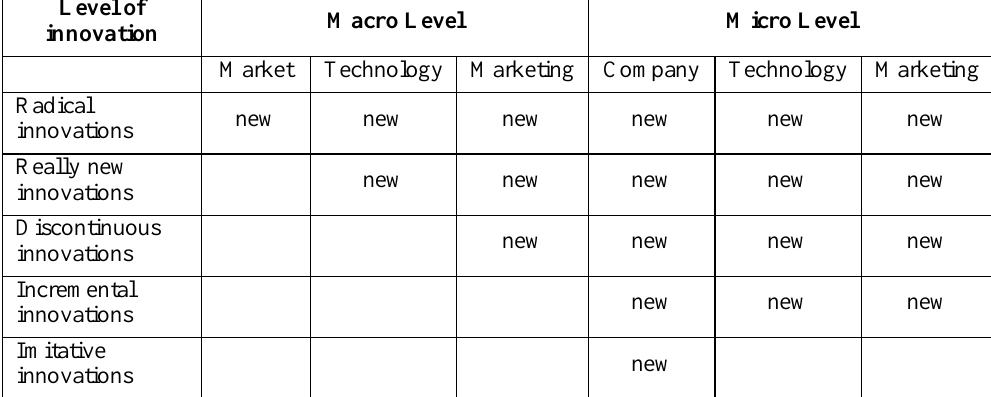
Table 1 . Classification of innovations, based on their innovativeness (created by the